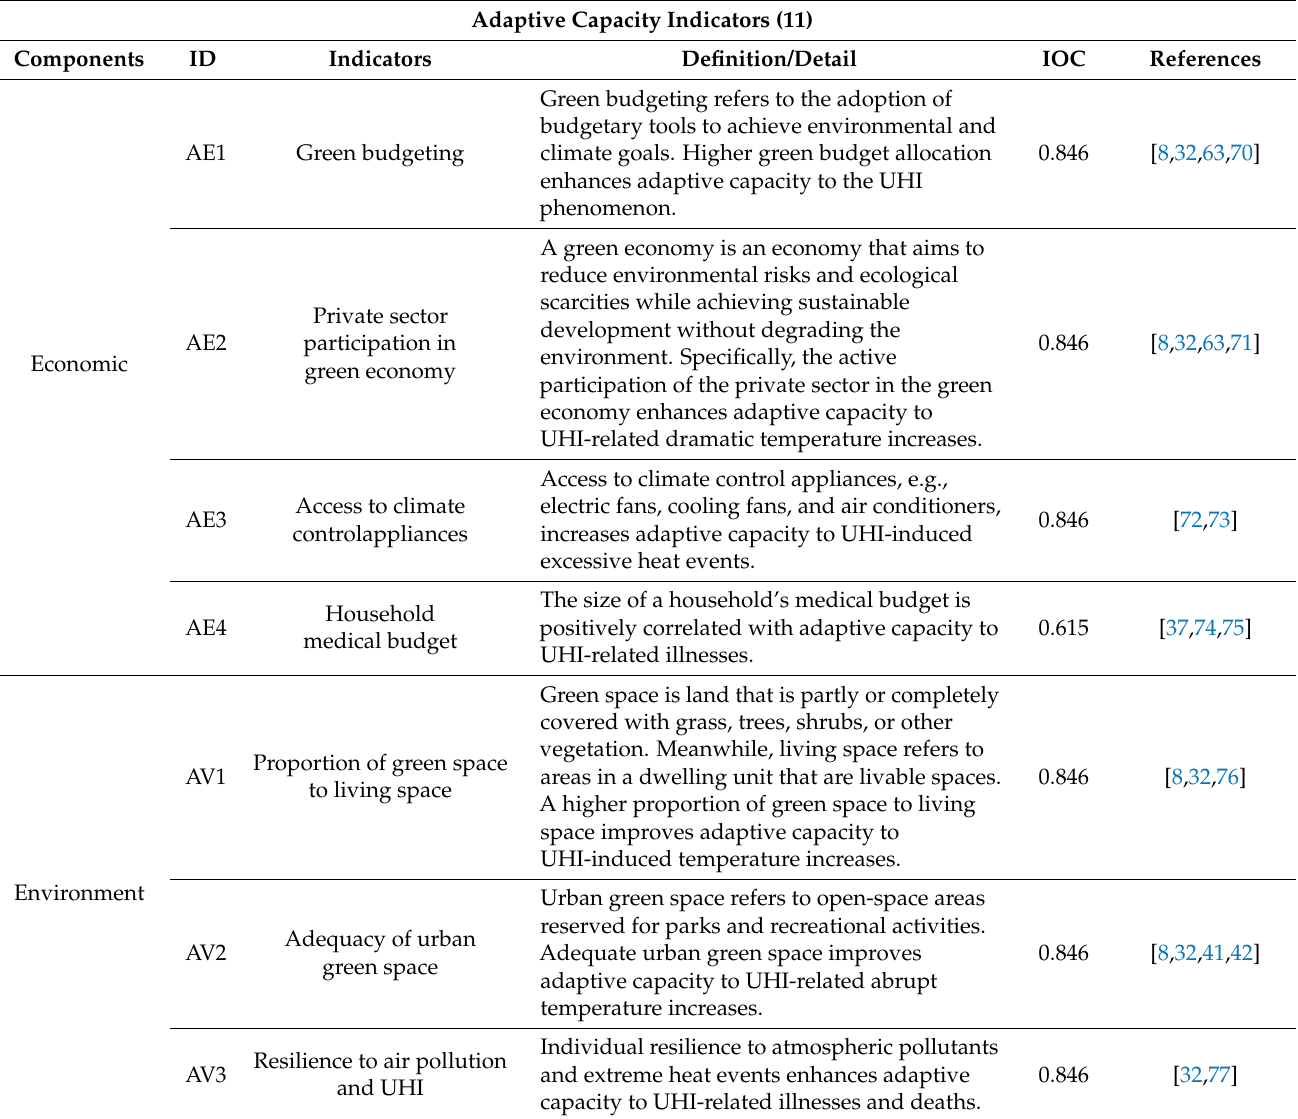
Table 4. Cont . Adaptive Capacity Indicators